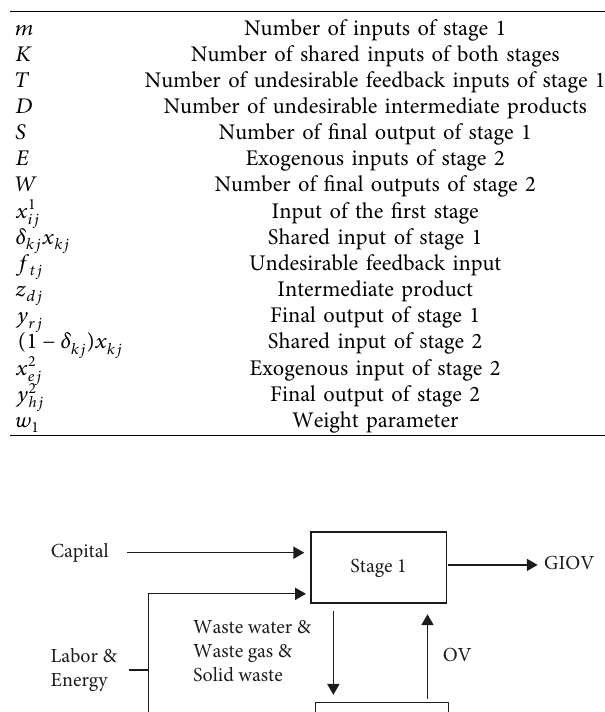
Table 1: Notations.